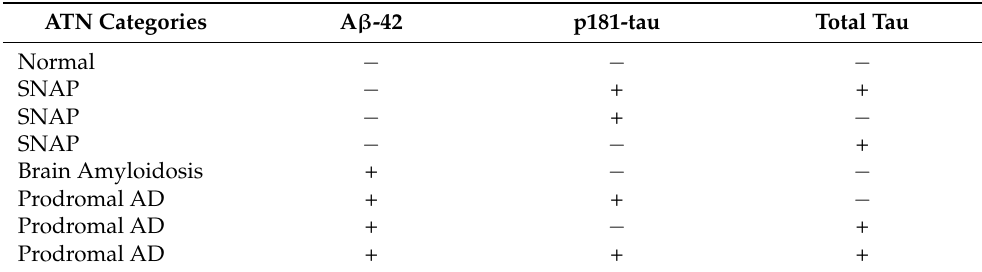
Table 7. Biomarkers results included in each ATN